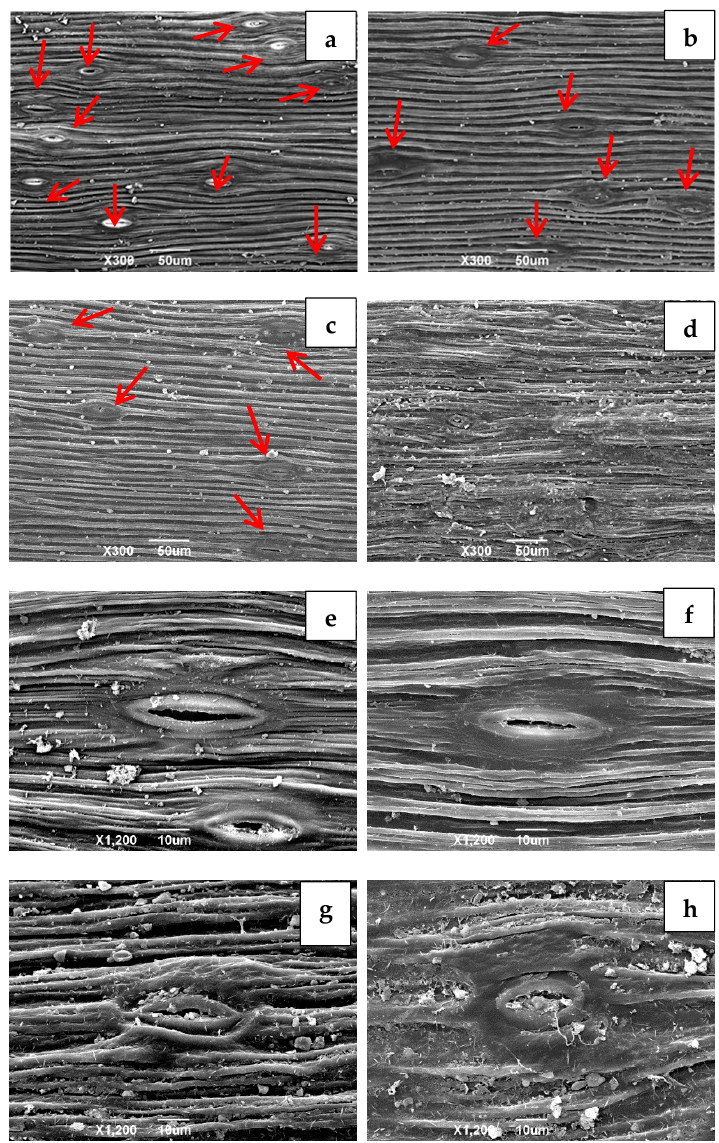
Figure 2. SEM micrographs of sweet cherry peduncle surface: ( a ) RL, ( b ) RN, ( c ) RA, ( d ) FS show the stomata number, wax distribution, and morphology on the peduncle at ×300 magnification; ( e ) RL, ( f ) RN, ( g ) RA, ( h ) FS show the stomata, wax distribution, and morphology at ×1200 magnification.